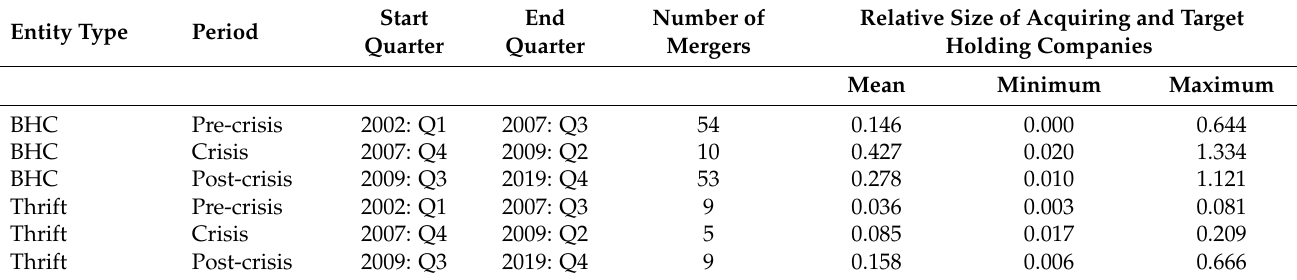
Table 3. Summary Statistics for Merger